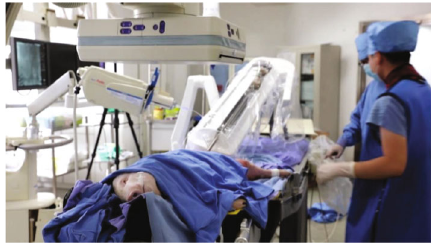
Figure 3: Prepared experimental Bama small pig.